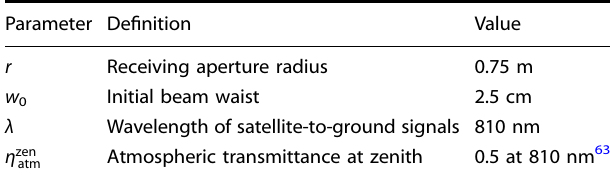
Table 3. Parameters used in the modeling of loss from satellites to ground stations.